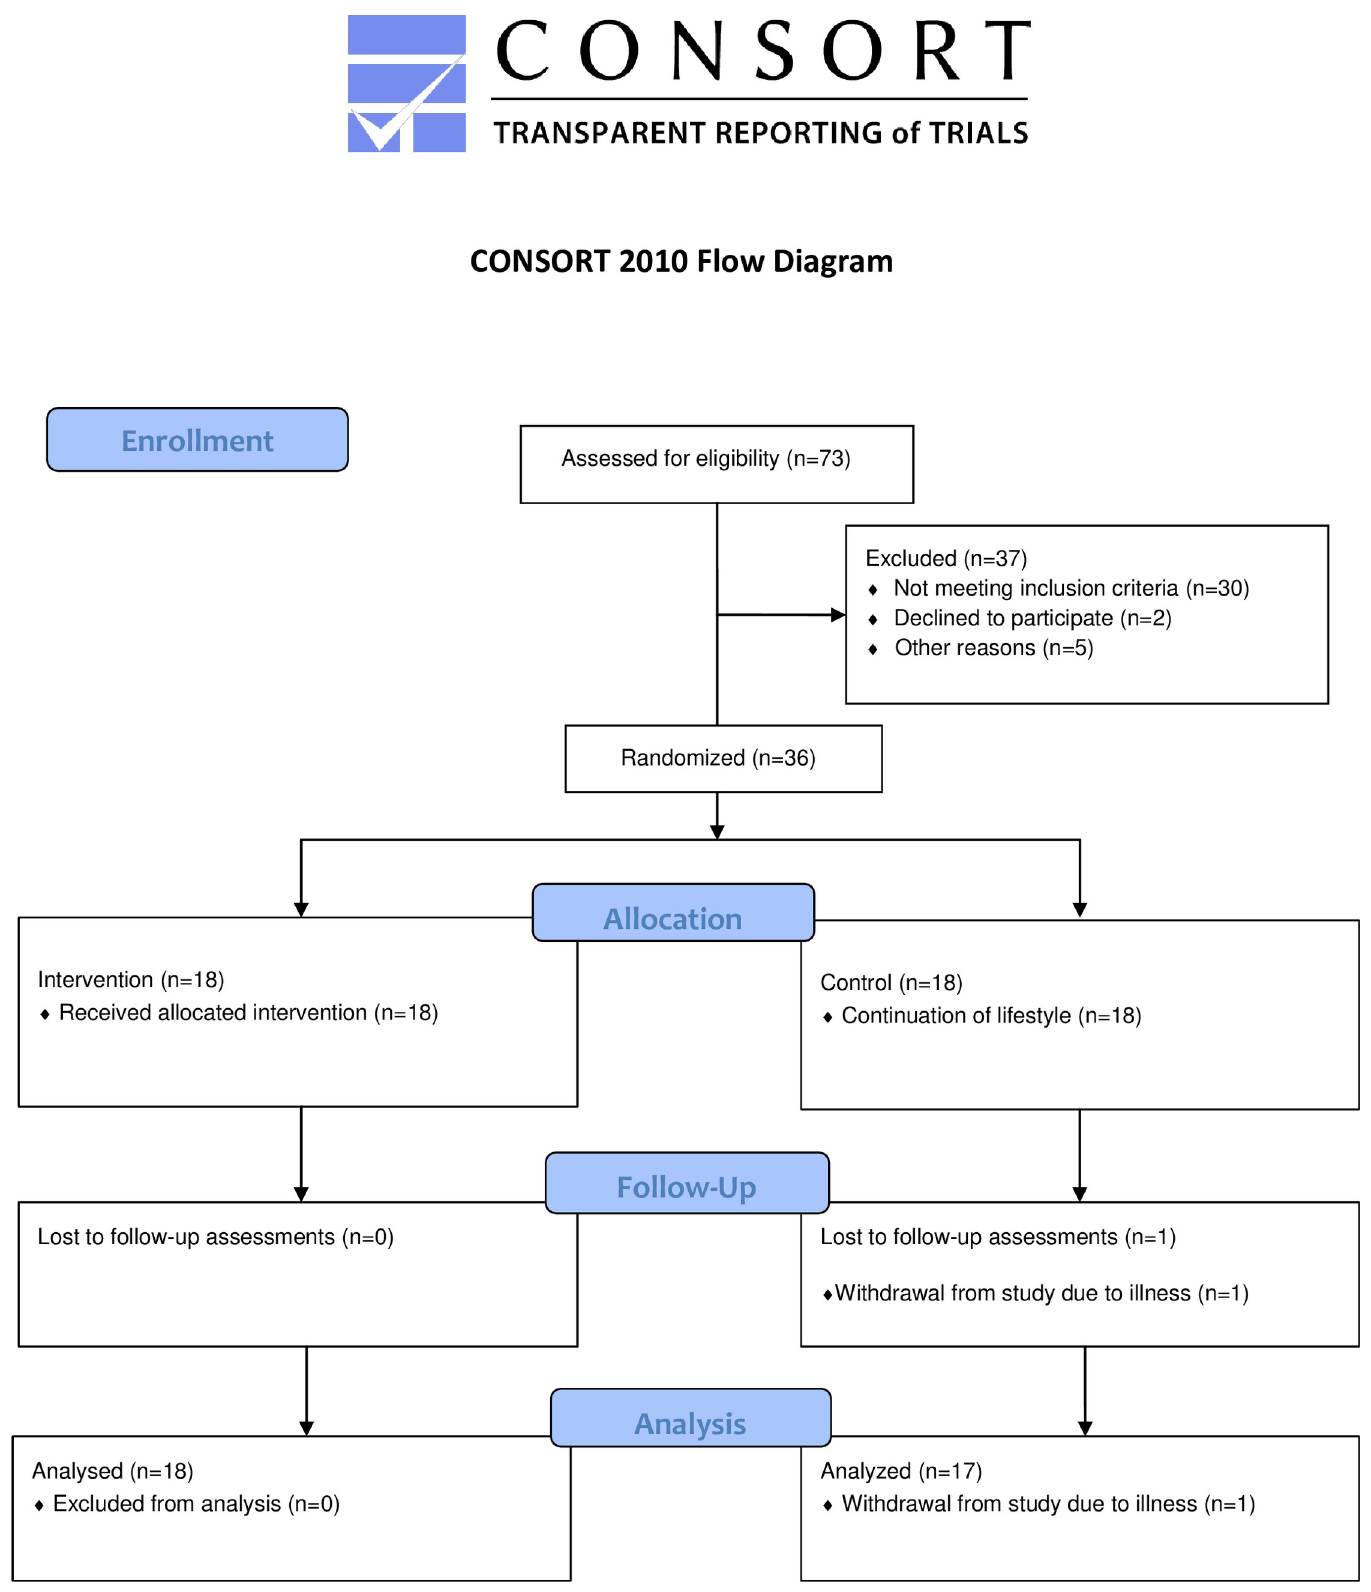
Fig 1. Participants flow. The study was conducted in Kristiansand, Norway, from September 2017 to June 2018.